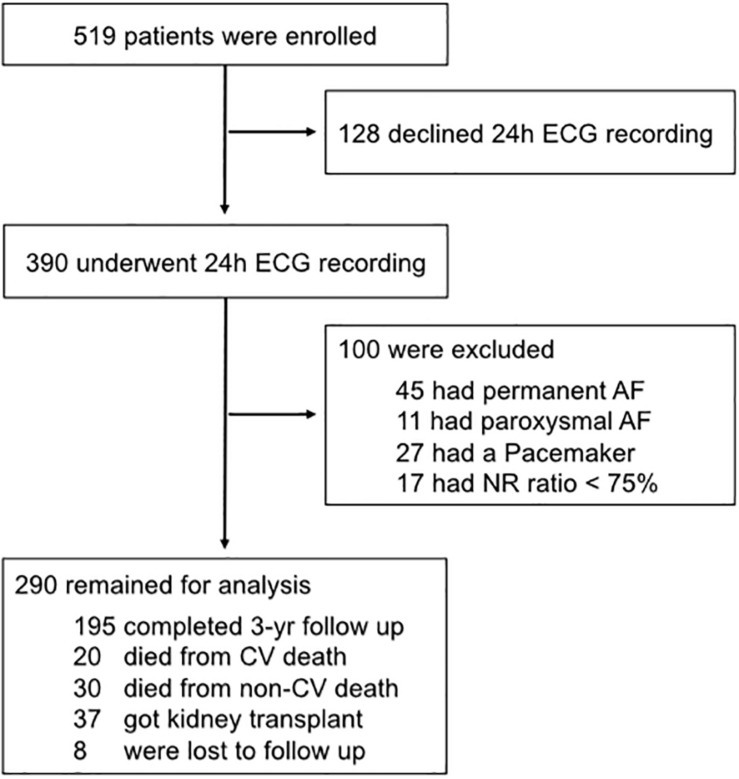
Flowchart of participants. Out of the 519 patients, 390 consented to undergo 24 h Holter electrocardiogram (ECG). Of these, 100 had to be excluded because of atrial fibrillation, a permanent pacemaker implant, or because of having less than 75% of normal sinus rhythm beats. 290 patients remained for the present analysis. AF, arterial fibrillation; CV, cardiovascular; ECG, electrocardiogram; NR, normal rhythm; yr, year.